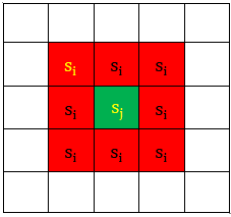
Figure 5. Diagram of structural elements state.